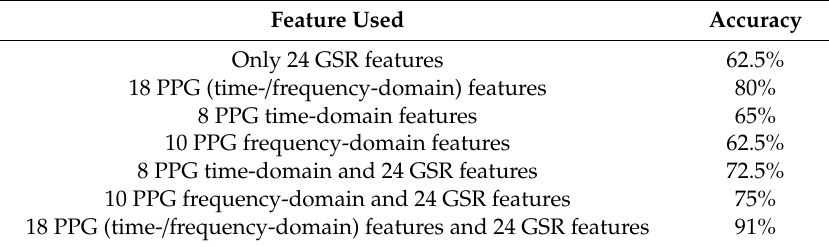
Table 2. Comparison of feature accuracy using five-fold cross-validation.